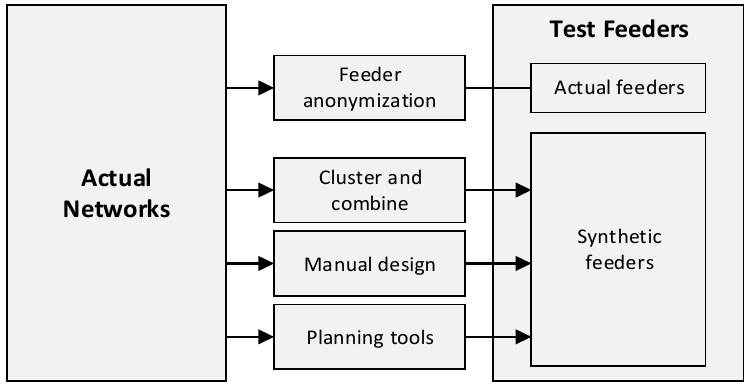
Figure 2. Test feeders building procedures.